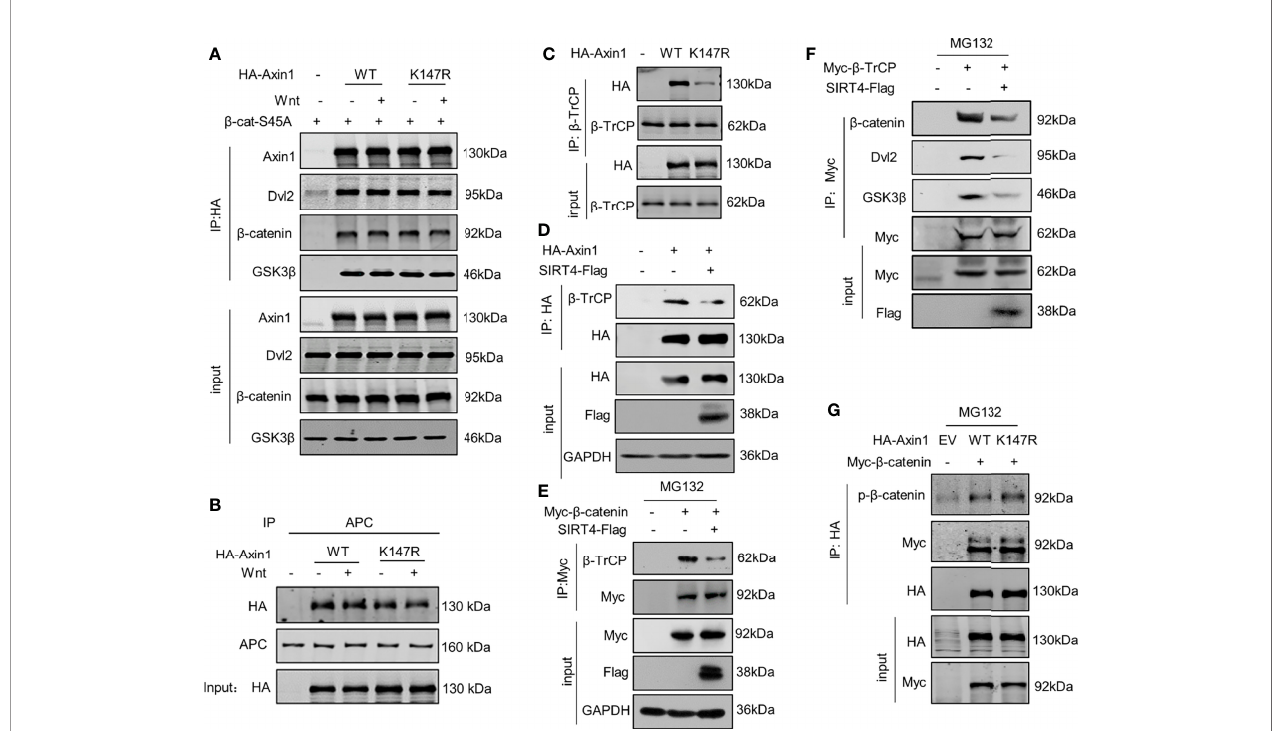
FIGURE 5 | SIRT4-catalyzed deacetylation of Axin1-K147 reduces accessibility of b -TrCP to the destruction complex. (A) Both WT and K147R mutant HA-tagged Axin1 were cotransfected with 6×Myc- b -catenin-S45A. Cells were treated with Wnt3a-conditioned medium as indicated for 30 minutes before samples were collected. HA-Axin1 was immunoprecipitated with anti-HA beads. Immunoprecipitated proteins were analyzed by western blotting with the indicated antibodies. (B) HA-Axin1-WT or HA-Axin1- K147R were transfected in HEK293T cells as indicated. The cells were treated with Wnt3a-conditioned medium for 30 minutes and then were collected and subjected to coimmunoprecipitation with anti-APC. Axin1 and APC were detected by western blot with anti-HA or anti-APC antibody respectively. (C) HEK293T cells were transfected with HA-Axin1-WT/K147R respectively, whole cell lysates were collected, b -TrCP was immunoprecipitated with anti- b -TrCP. Both whole cell lysates and precipitates were analyzed by western blot with the indicated antibodies. (D) HEK293T cells were cotransfected with HA-Axin1 and SIRT4-Flag as indicated, whole cell lysates were collected, HA-Axin1 was immunoprecipitated with anti-HA. Both whole cell lysates and precipitates were analyzed by western blot with the indicated antibodies. (E) HEK293T cells were cotransfected with Myc- b -catenin and SIRT4-Flag as indicated, and then treated with 10 mM MG132 for 4 h, the whole cell lysates were collected, Myc- b -catenin was immunoprecipitated with anti-Myc. Both whole cell lysates and precipitates were analyzed by western blot with the indicated antibodies. (F) HEK293T cells were cotransfected with Myc- b -TrCP and SIRT4-Flag as indicated, and then treated with 10 mM MG132 for 4 h, the whole cell lysates were collected, Myc- b -TrCP was immunoprecipitated with anti-Myc. Both whole cell lysates and precipitates were analyzed by western blot with indicated antibodies. (G) HEK293T cells were cotransfected with Myc- b -catenin and HA- Axin1 (WT or K147R) as indicated with treated 10 mM MG132 for 4 h, and then whole cell lysates were collected, HA-Axin1 was immunoprecipitated with anti-HA. Both whole cell lysates and precipitates were analyzed by western blot with indicated